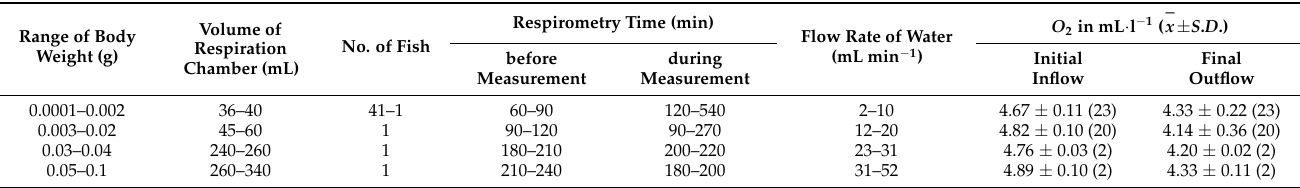
Table 1. Summary of respirometry system based on the micro-semi-closed